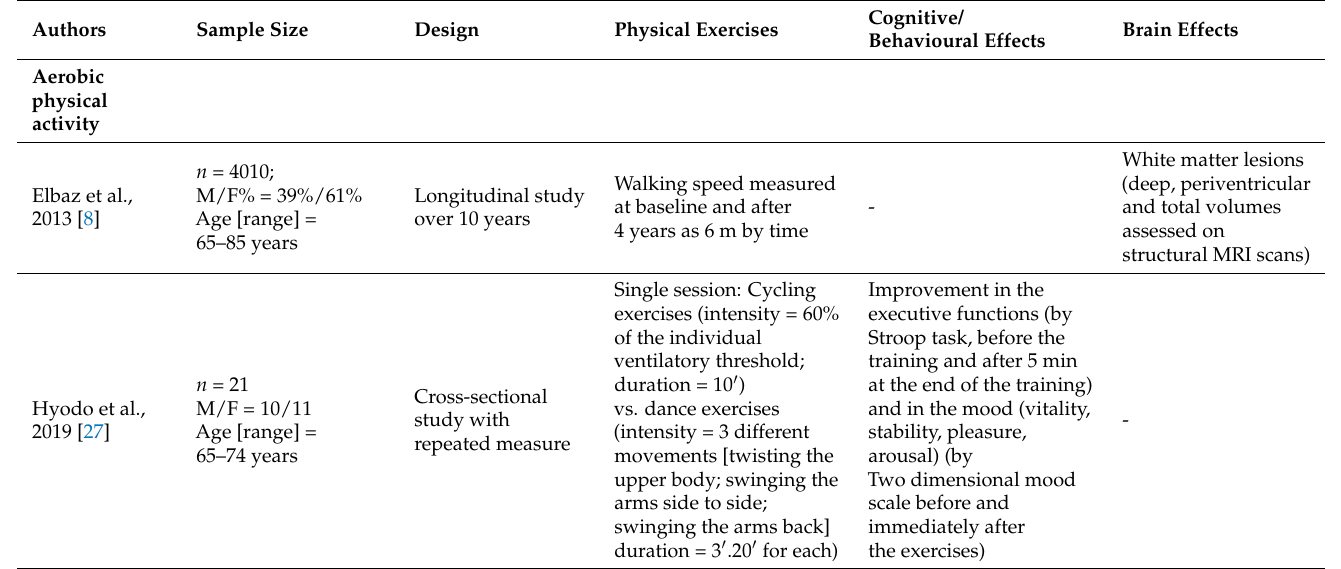
Table 1. Studies on aerobic exercise effects on cognitive functions and neural substrates of healthy human